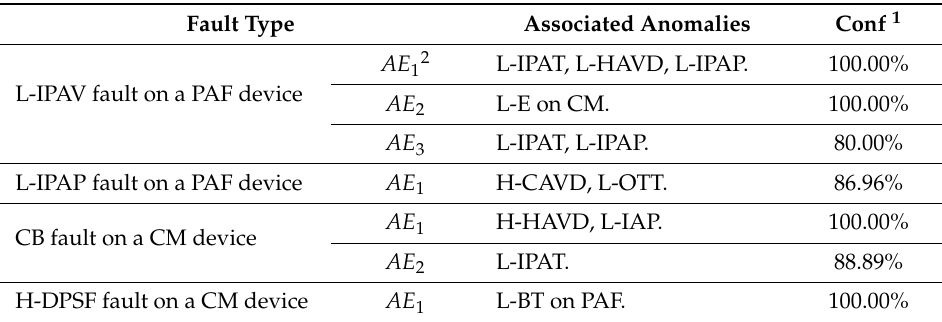
Table 2. Faults and its associated events.